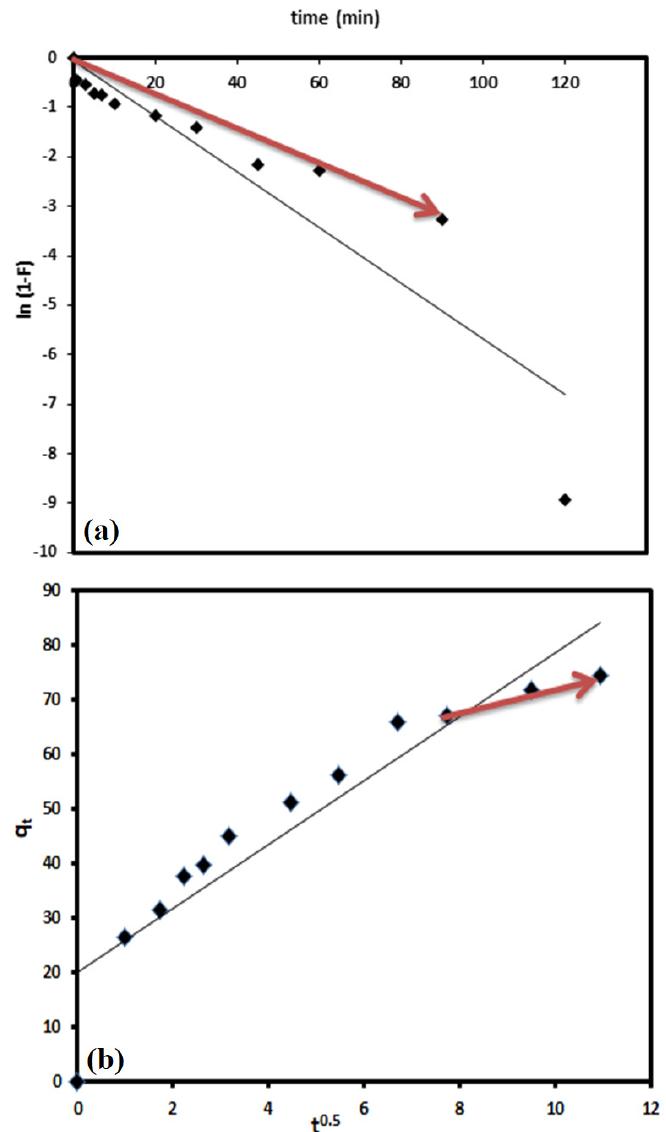
Figure 13. Liquid film diffusion plot ( a ) and intraparticle diffusion plot ( b ) for the removal of DV31 dye from an aqueous solution by G CuO NPs. (Experimental conditions: DV31 concentration 25 mg/L; 1 mL H 2 O 2 ; sample volume 200 mL; 20.0 mg CuO NPs; pH 8.6 and temperature at 25 °C).